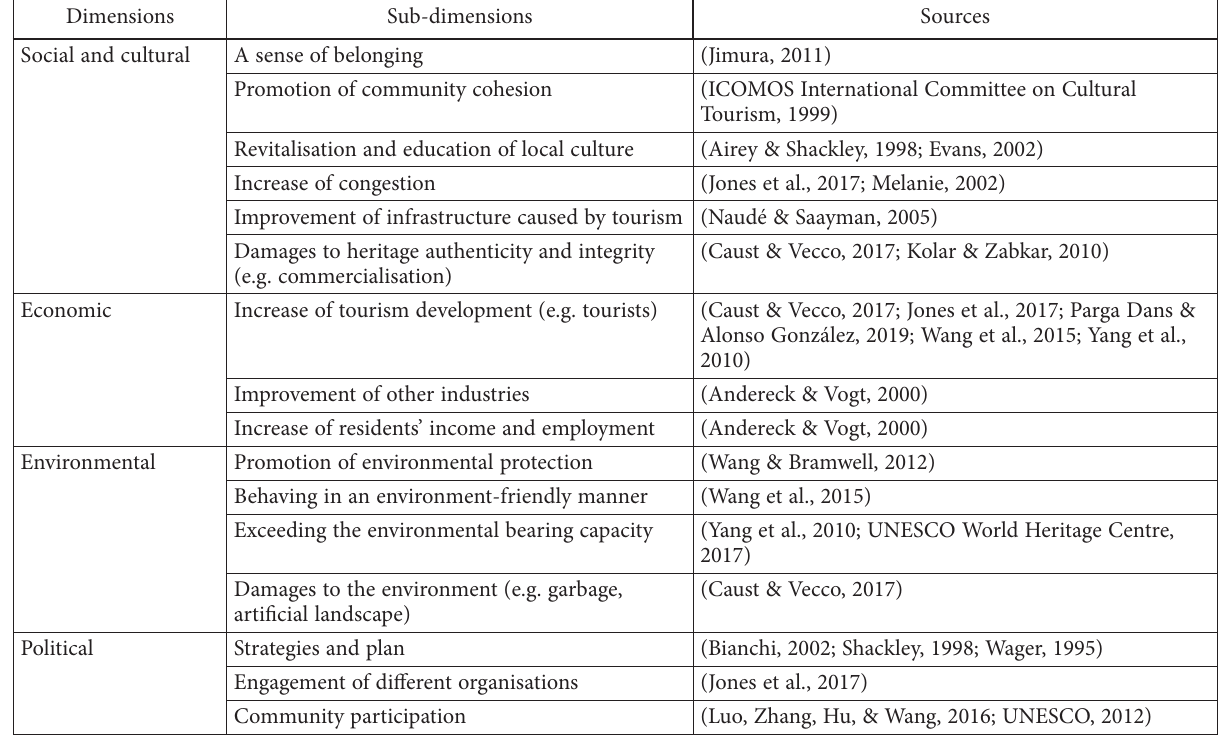
Table 1. Factors on the impacts of the WHL